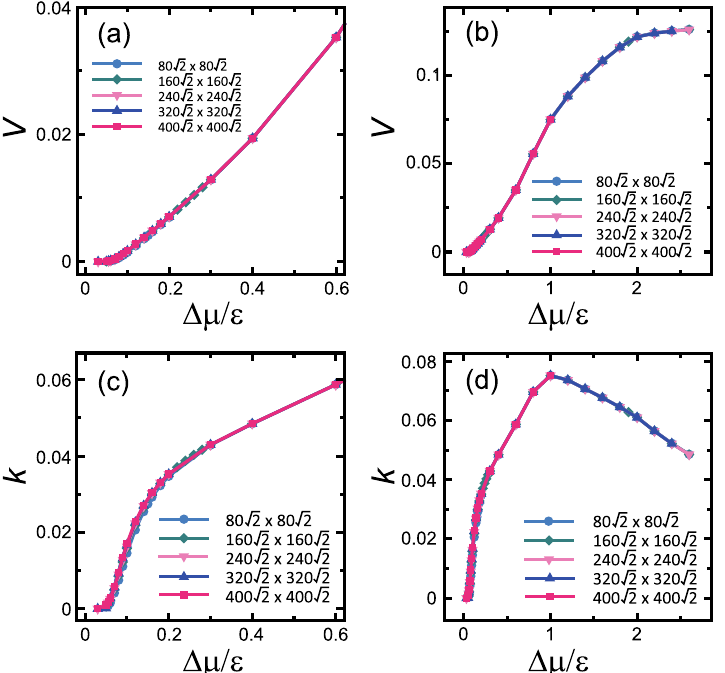
Figure 3. ( a , b ) Driving force dependence of the surface growth velocity. ( c , d ) Driving force dependence of the kinetic coefficient. k B T /ǫ